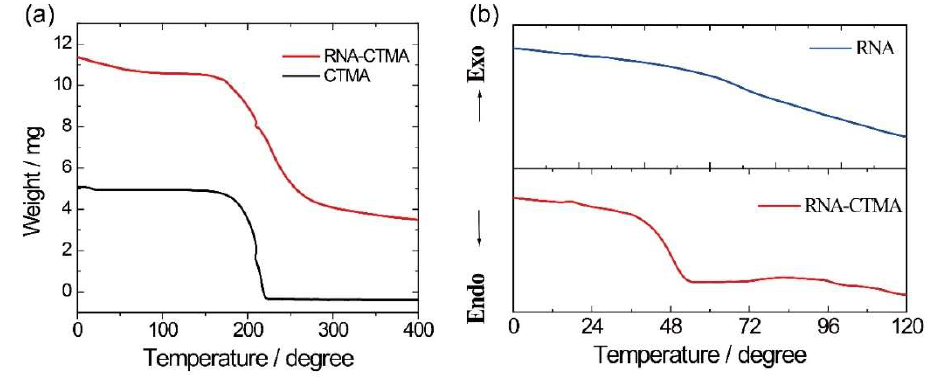
Figure 4. ( a ) Thermogravimetric (TG) curves of CTMA and RNA–CTMA. ( b ) The DSC curve of the RNA and RNA–CTMA complex.